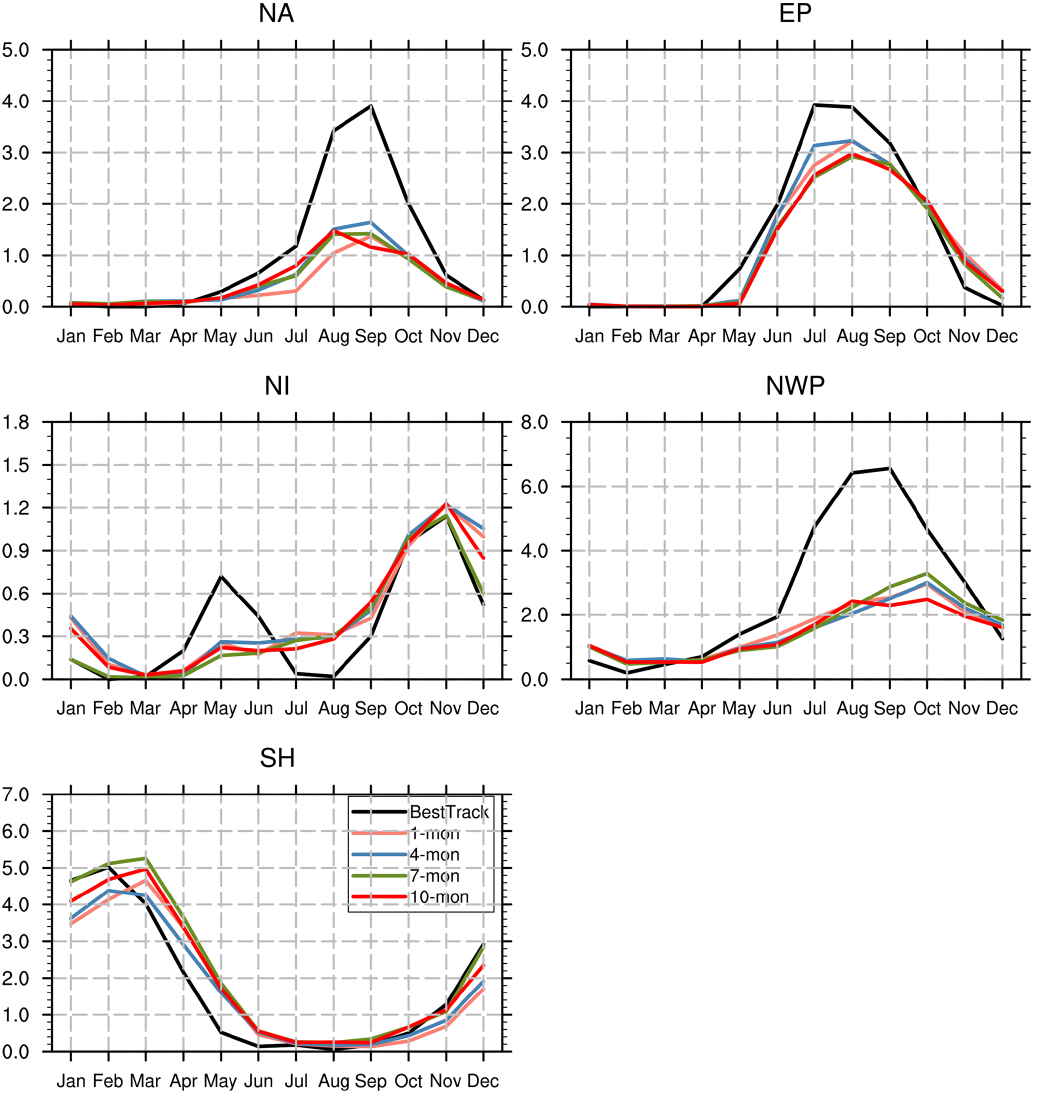
Figure B9. Climatological mean TC number seasonality in observations (black curves) and SMYLE forecast at 1-month (orange), 4-month (blue), 7-month (green), and 10-month (red) lead time in different TC basins – North Atlantic (NA), eastern Pacific (EP), north Indian Ocean (NI), northwestern Pacific (NWP), and Southern Hemisphere